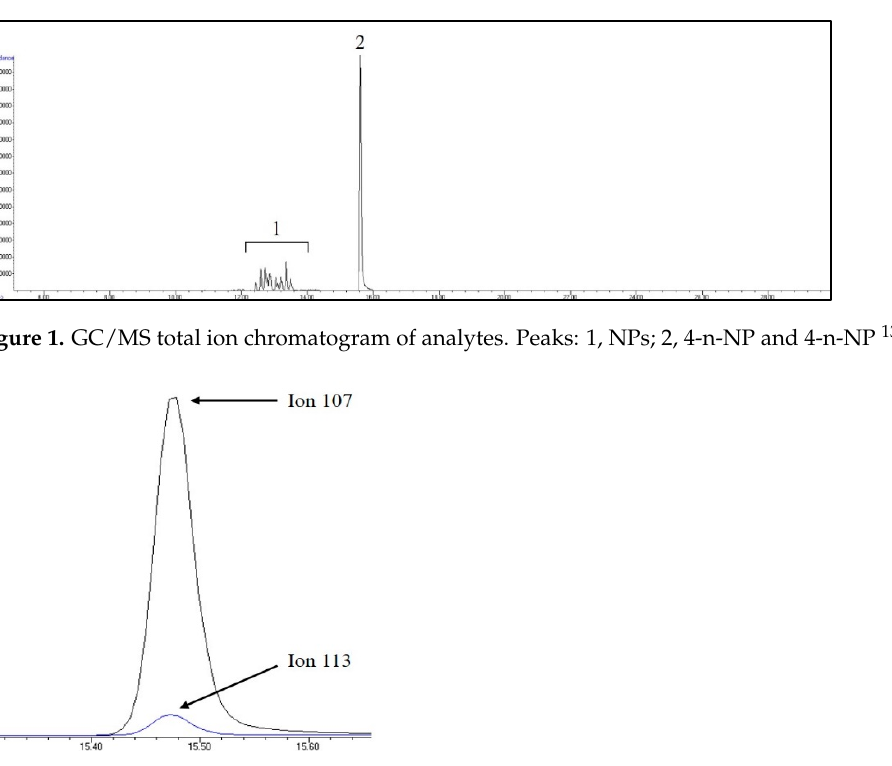
Foods 2023 , 12 , x FOR PEER REVIEW